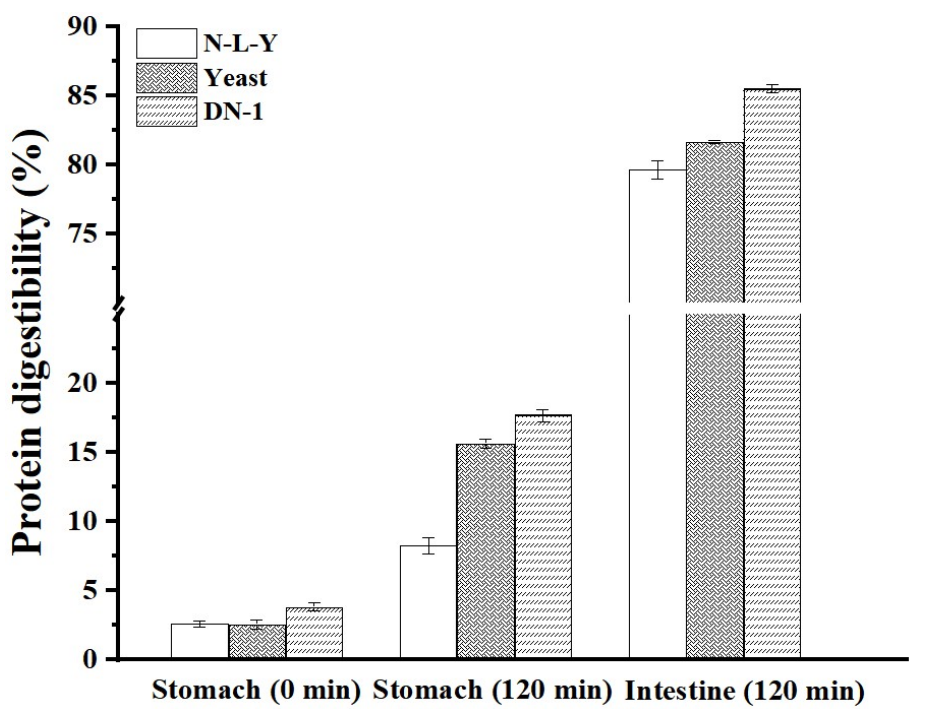
Figure 1. Protein digestibility of crackers in the stomach and intestine. N-L-Y: Crackers made without yeast and LP HLJ29L2 co-fermentation; yeast: Crackers made with yeast fermentation alone; DN-1: Crackers made with LP HLJ29L2 and yeast co-fermentation.